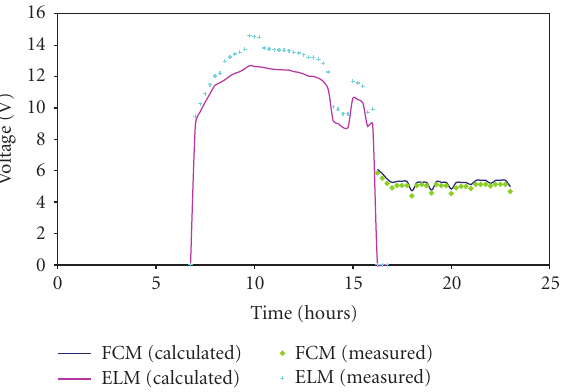
Figure 8: Simulated and measured hydrogen tank